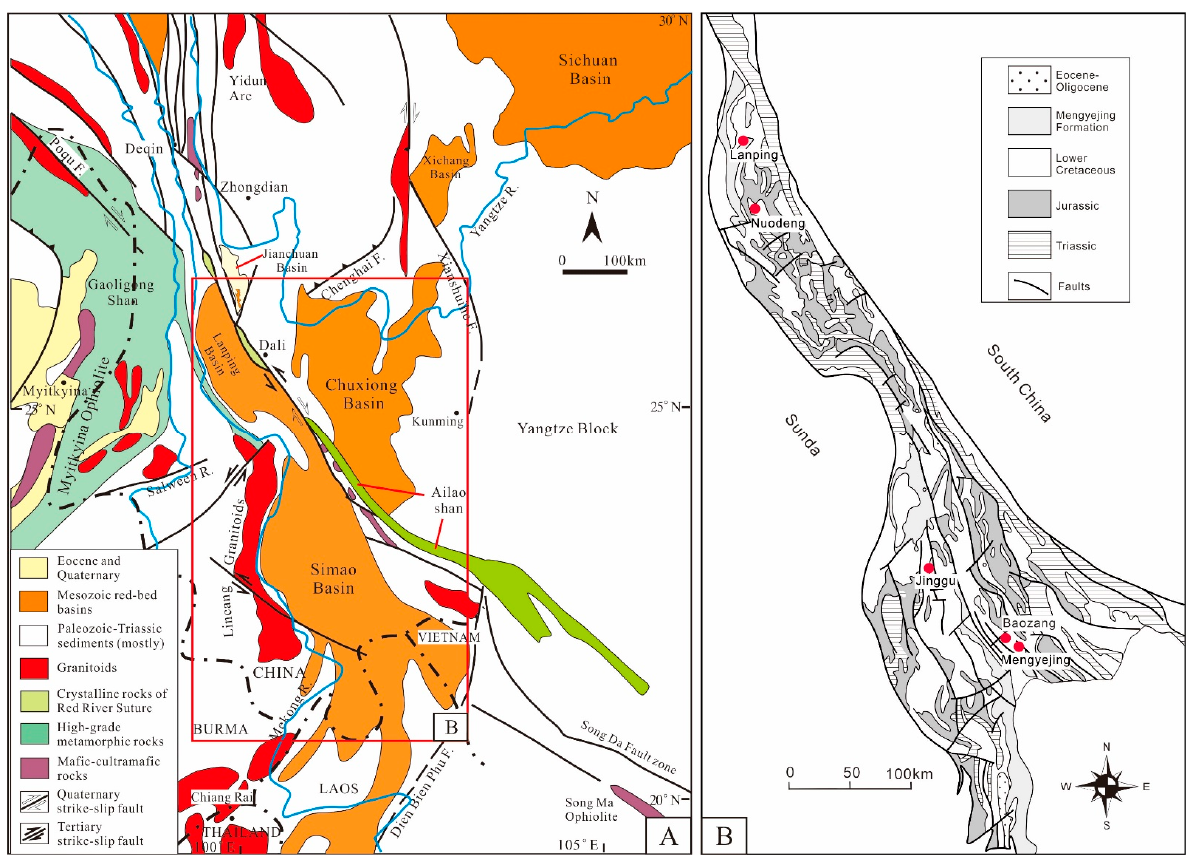
Figure 1. ( A ) Schematic map of major tectonic features of western Yunnan (after [29]); ( B ) schematic geological map of Lanping–Simao Basin and sampling locations (marked by red dots) (after [27]).